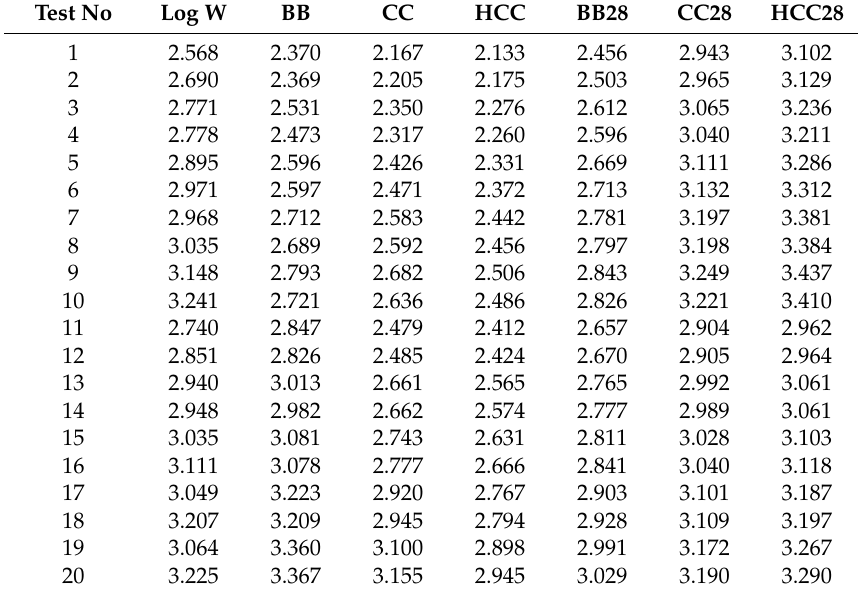
Table 12. Predicted results of the six RSM equations and measured results of 20 samples.